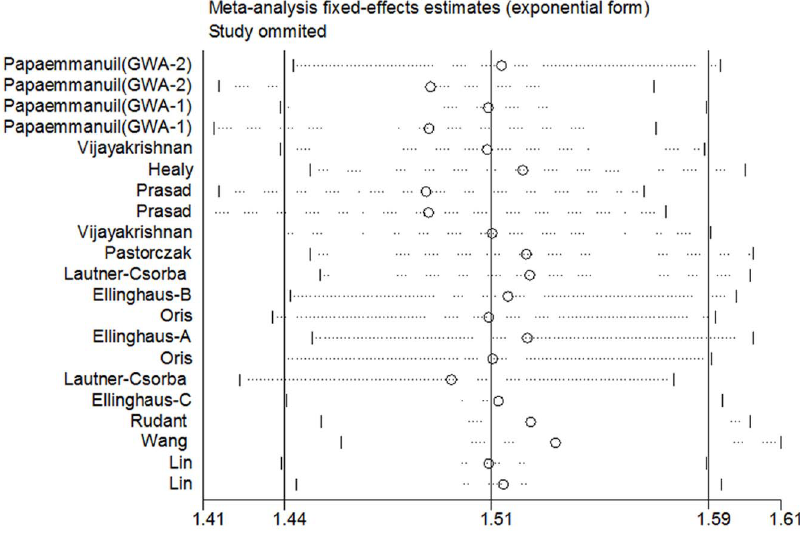
Figure 3. Sensitivity analysis on the associations between IKZF1 rs4132601 variant and childhood AL risk in allelic contrast model (G vs T). Results were computed by omitting each study (left column) in turn, Bars: 95% confidence